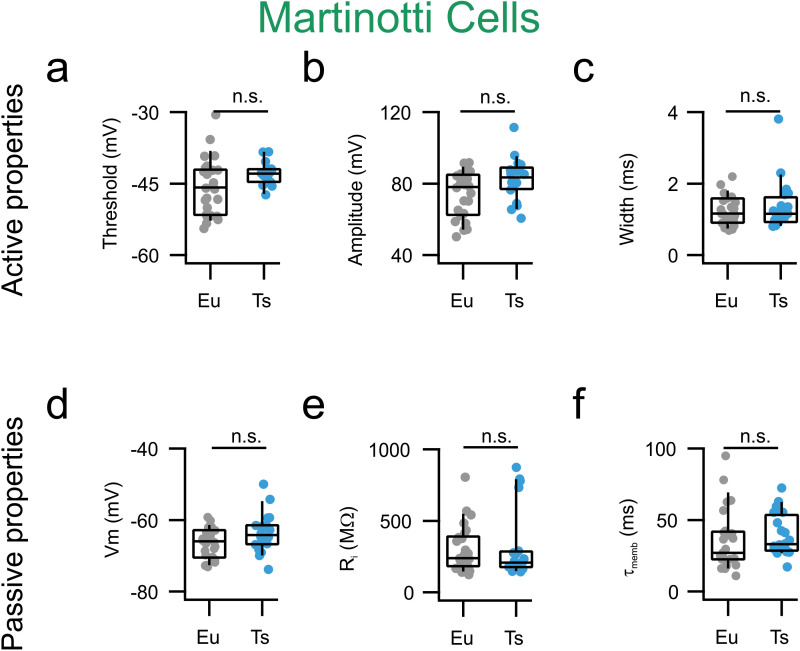
Active and passive properties are normal in mPFC MCs from Ts65Dn mice.(a) AP thresholds estimated as the voltage at which the derivative of Vm as function of time (dV/dt) reaches the limit of 10 mV/ms. Eu: −46, −52–42 (n = 23 cells); Ts: −43, −45–42 (n = 25 cells, p=0.09877, Mann-Whitney U-test). (b) AP amplitude measured as the difference between Vm at threshold and Vm at peak Eu: 79, 63–85 mV (n = 26 cells), Ts: 82, 69–85 mV (n = 20, p=0.07267, Mann-Whitney U-test). (c) AP width. Eu: 1.2, 0.9–1.6 ms (n = 26 cells), Ts: 1.2, 0.9–1.6 ms (n = 20 cells, p=0.8680, Mann-Whitney U-test). (d) Resting membrane potential. Eu: −66, −70–63 (n = 26 cells), Ts: −64, −67–62 (n = 20 cells, p=0.0566, Mann-Whitney U-test). (e) Input resistance, Eu: 238, 183–382 MΩ (n = 26 cells), Ts: 207, 176–282 MΩ (n = 20 cells, p=0.57205, Mann-Whitney U-test). (f) Decay tau of the membrane Eu: 27, 22–41 (n = 26 cells), Ts: 33, 29–52 (n = 20 cells, p=0.14067, Mann-Whitney U-test). Boxplots: represent median, percentiles 25 and 75 and whiskers are percentiles 5 and 95. Individual points represent average values from each recorded synaptic connection.Figure 2—figure supplement 2—source data 1.Singleaction potentialand passive properties of mPFC MCs.